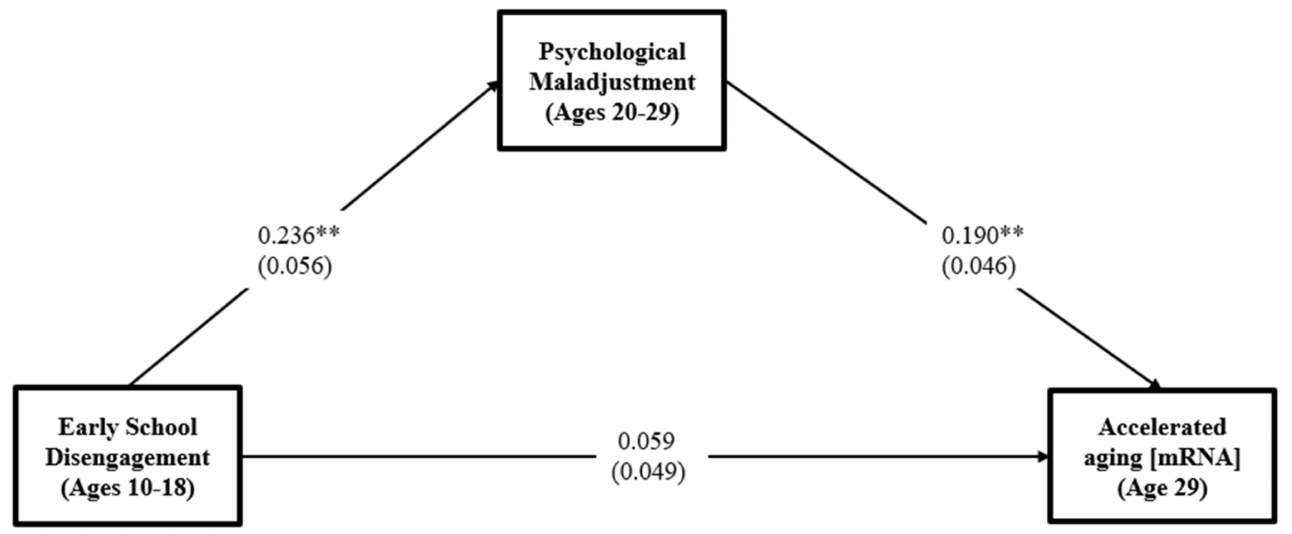
Figure 1. Effects of school disengagement on accelerated aging at age 29 through psychological maladjustment. The model is saturated. Values are standardized parameter estimates, and standard errors are in parentheses. Gender, education, healthy diet, exercise, alcohol consumption, and smoking are controlled in these analyses. ** p ≤ 0.01, * p ≤ 0.05 (two-tailed tests), n =